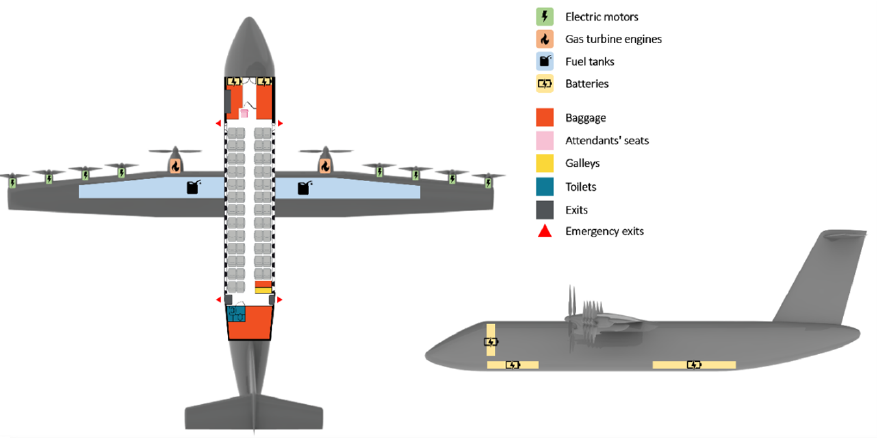
Figure 6. Schematic representation of the ICE-based hybrid-electric configuration